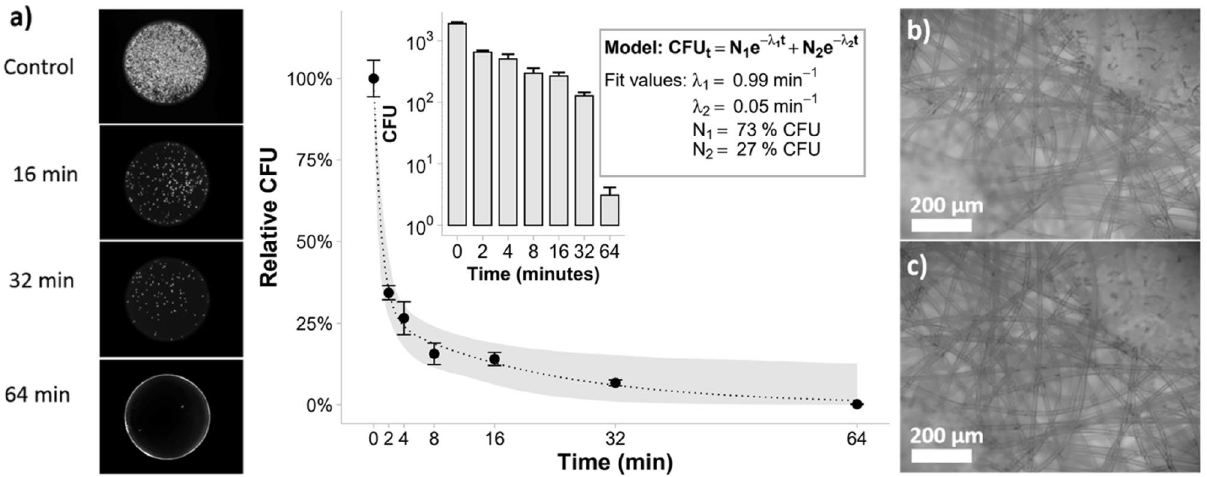
Figure 6. Bacterial decontamination of surgical masks over time. ( a ) Fluorscent images of colony growth on agar after varying decontamination times are portrayed on the left. The image at 64 min (bottom) is overexposed as only a single colony was observed (red). In the scatter plot, each point represents the mean and S.E.M. from three technical replicates that were normalized by their respective control’s mean CFU (mean of control’s CFU was 10 3.42 ). Relative CFU were modelled as the sum of two exponential decays. The gray ribbon represents a